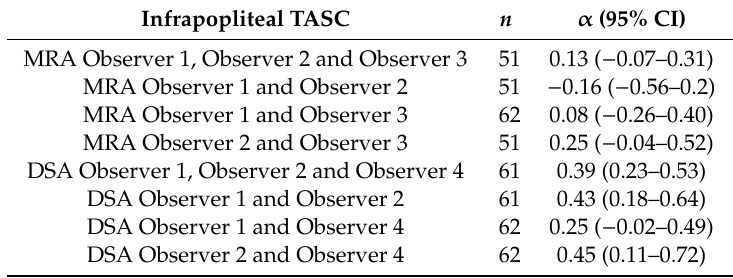
Table 2. Krippendor ff ’s alpha (95% CI) for interobserver agreement on assessed infrapopliteal TASC grade.